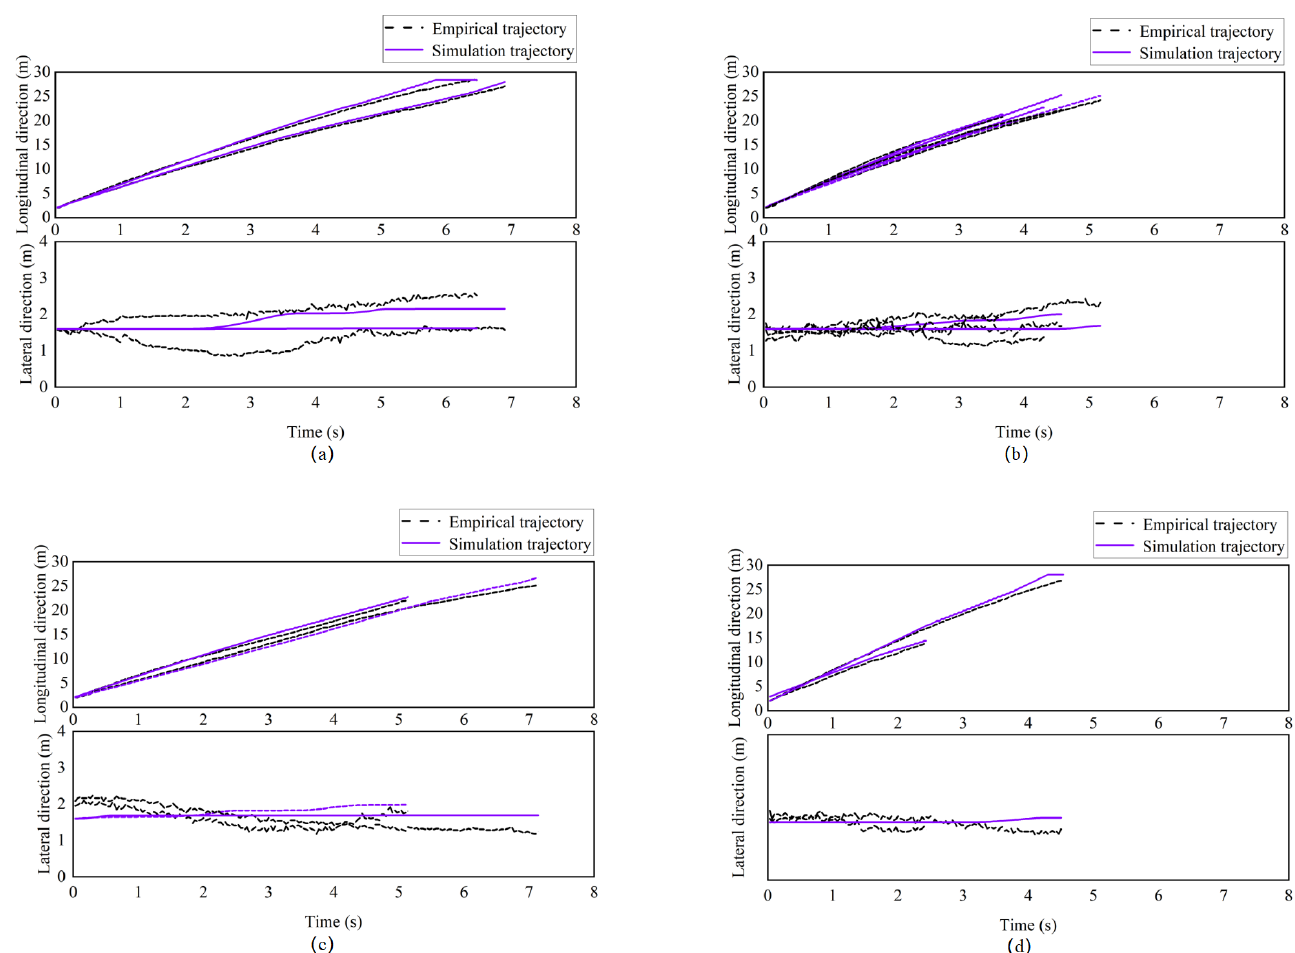
Figure 8. Rider follows the decision-making process. ( a ) Bike following bike. ( b ) Electric vehicles follow electric vehicles. ( c ) Bikes follow electric vehicles. ( d ) Electric vehicle following